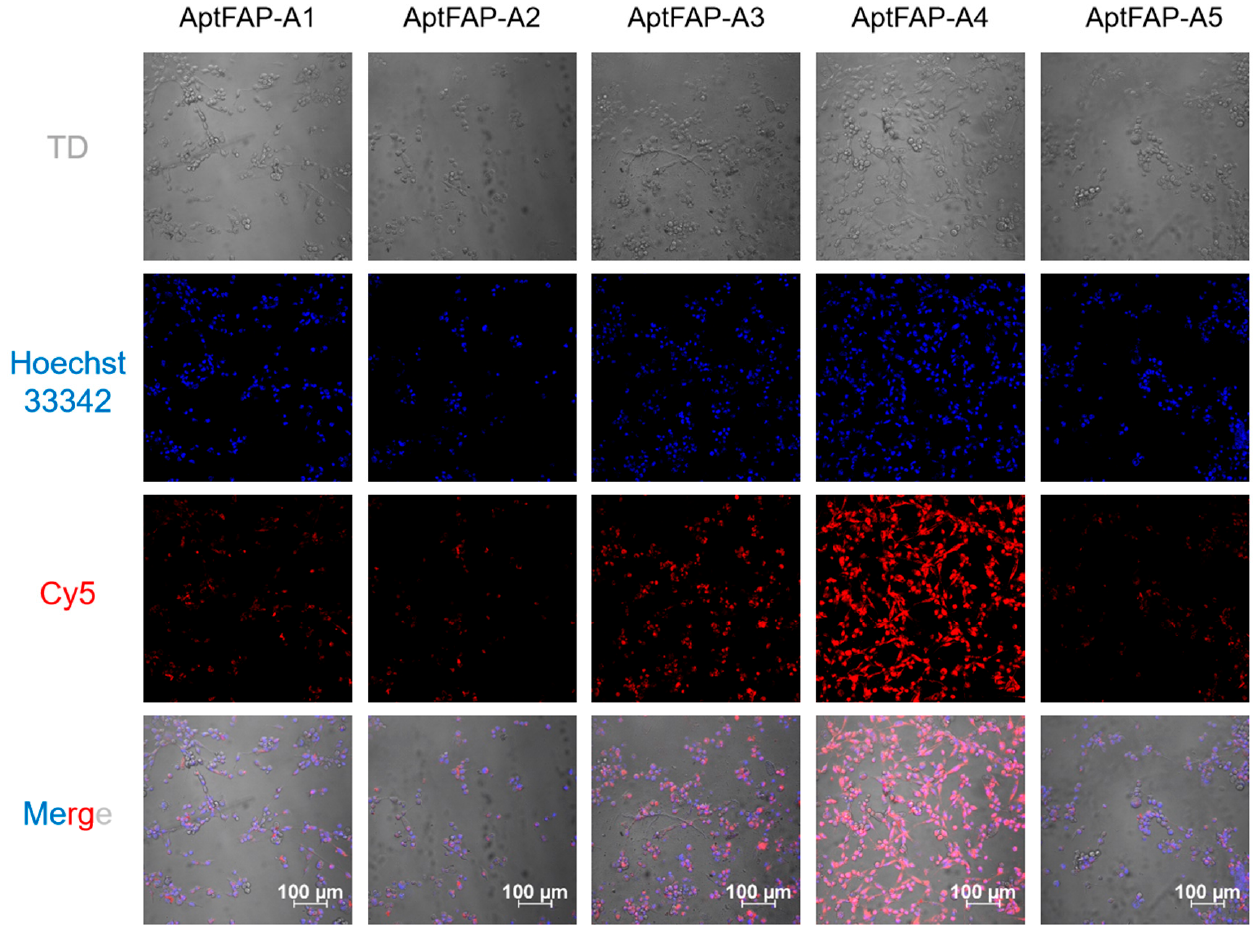
Figure 7. Binding of candidate aptamers to target cells. At the cellular level, AptFAP-A4 showed the highest affinity for target cells.